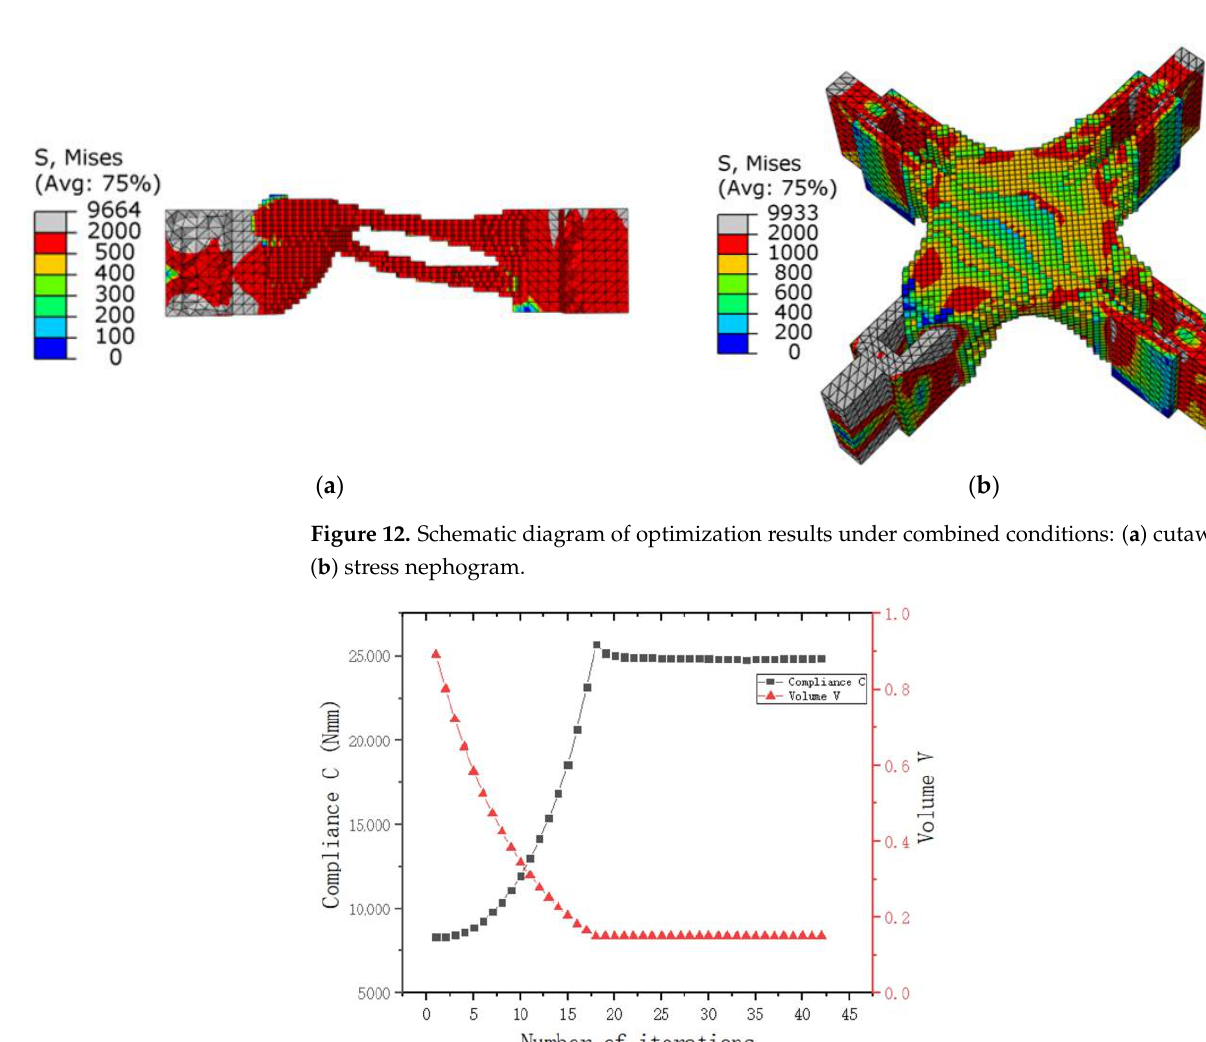
11 of 18 Figure 11. Optimization process under shearing conditions (the black dotted line is the change curve of compliance C, and the red dotted line is the volume-reduction curve). 3.3.3. Combined Load Conditions In the same way, the combined working condition analysis was carried out. Figures 12 and 13 show the optimization results and the optimization process under the combined load, respectively. Figure 12a shows that the force transfer paths of the whole structure were effectively utilized, and Figure 12b shows that the stress distribution